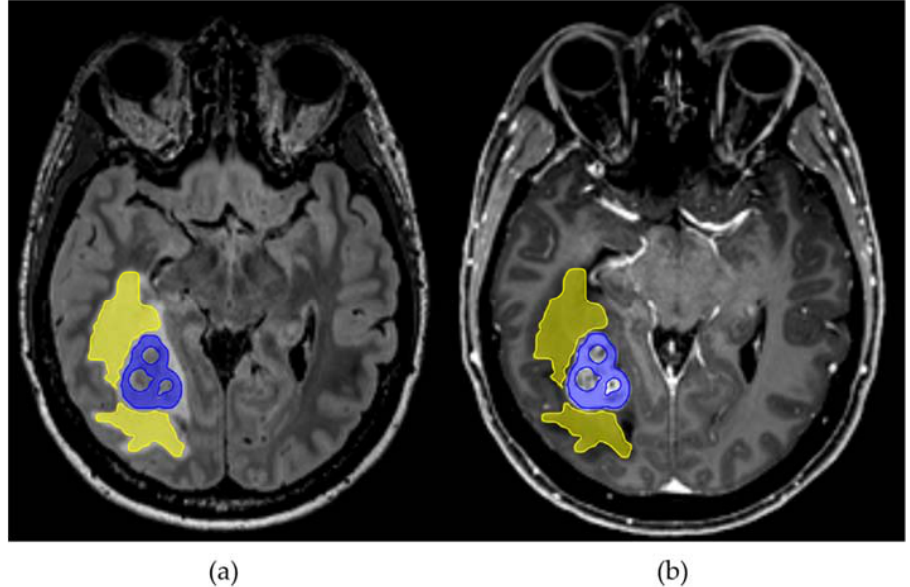
Figure 2. Axial FLAIR ( a ) and T1 MPRAGE post-Gd ( b ) images in a patient with a right occipital brain metastasis with corresponding perilesional FLAIR-hyperintensity (yellow) and contrast-enhancing tumor (blue) segmentations.